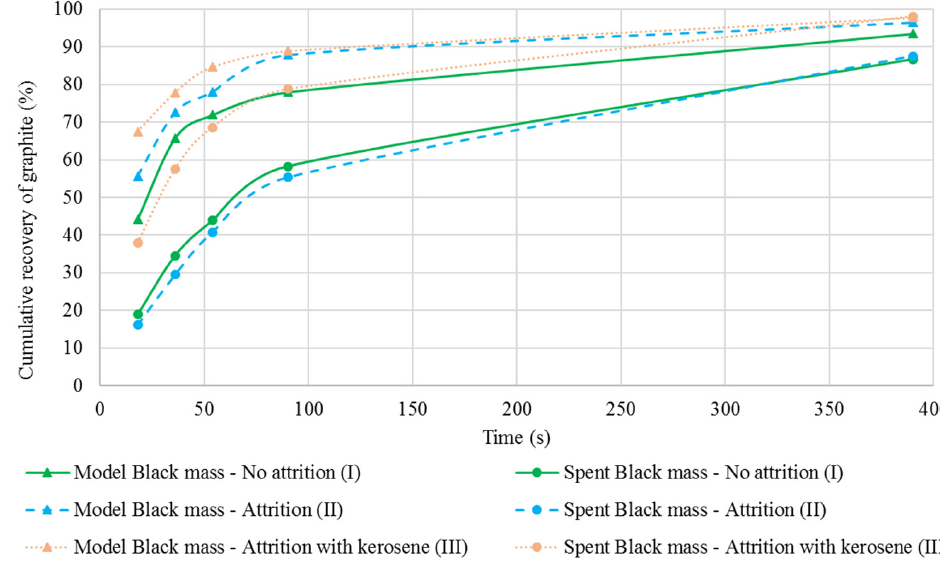
Figure 9. Carbon recovery from the spent black mass and model black mass in the overflow product according to the flotation time.